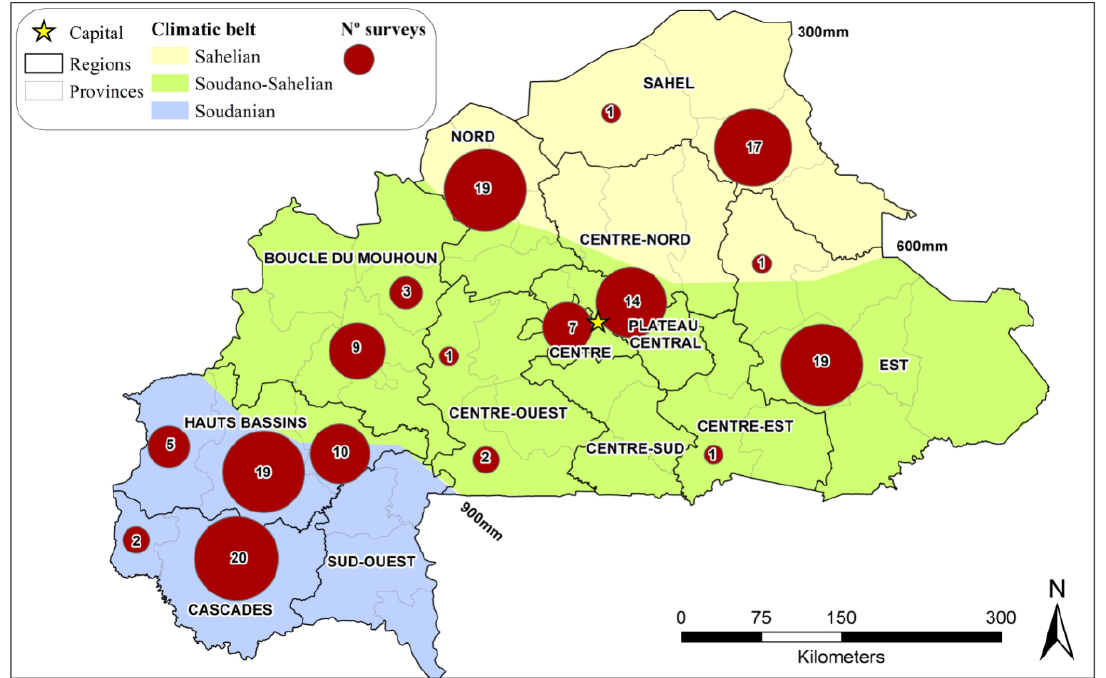
Figure 1. Spatial distribution of surveys along the different agroclimatic zones (Sahelian, Soudano-Sahelian, and Soudanian).